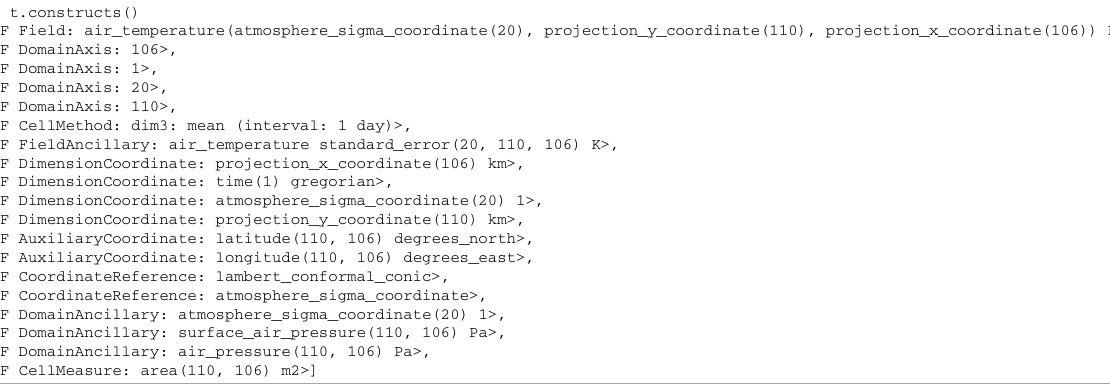
dinate objects (as dimension coordinate constructs can only exist within a field construct; see Sect. 4.1). As is the case with referenced variables, it is possible to override the default behaviour such that an independent field object is instanti- ated from each coordinate variable. This example highlights the issues arising from the absence of an explicit domain el- ement in CF (Sect.